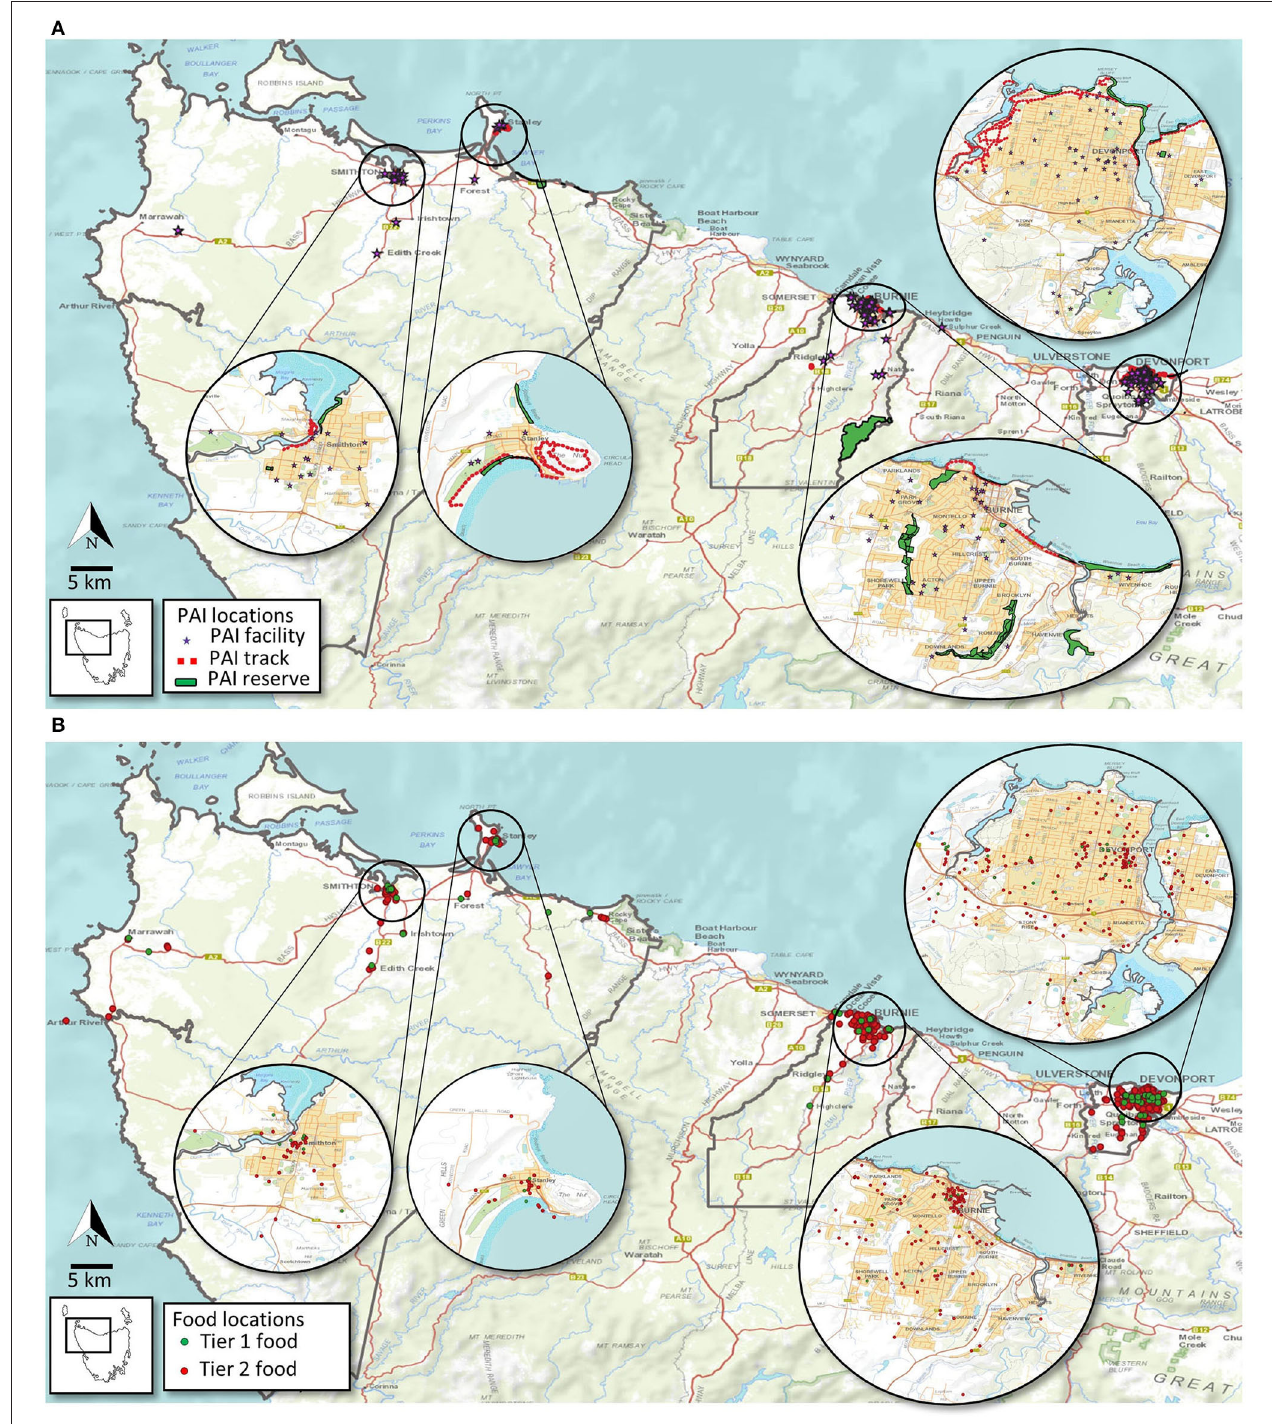
FIGURE 2 | Spatial distribution of PA infrastructure (A) and food outlets (B) across the study area.